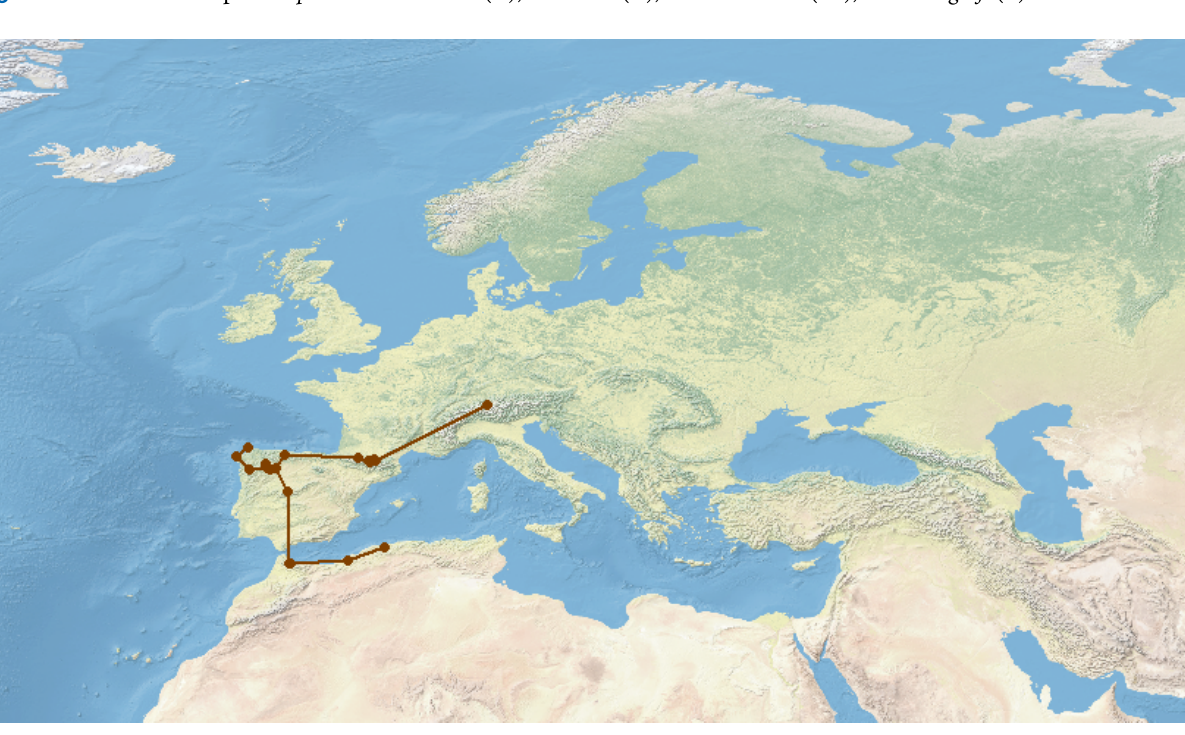
Figure 1. Distribution map of Diaptomus barabinensis ( ● ), D. charini ( ■ ), D. kostromanus ( ▲ ), and D. zografi ( ♦ ).